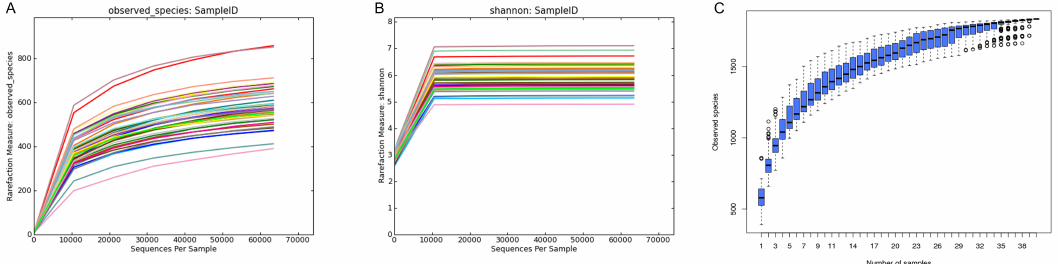
Figure 4. The rarefaction curve and Shannon curve. ( A ) Rarefaction curve of the o ff spring’s gut microbiota, ( B ) Shannon curve of o ff spring gut microbiota, ( C ) species cumulative box plot of o ff spring gut